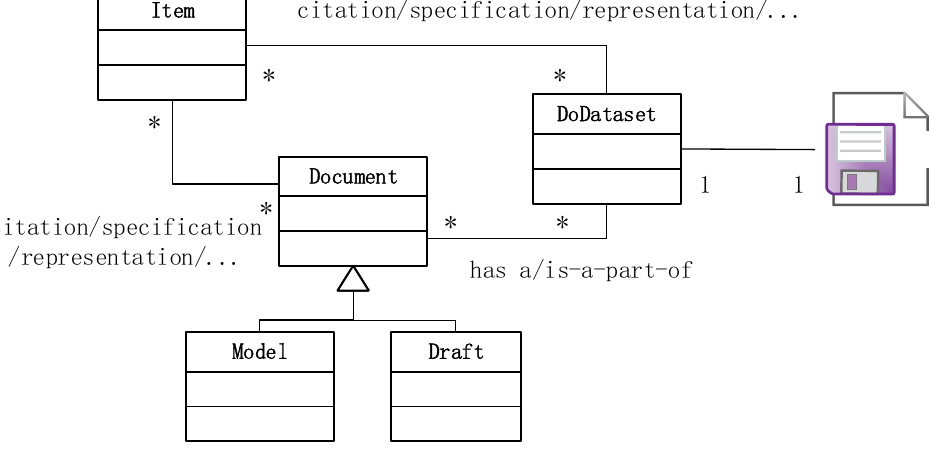
Figure 11. Document Management Data Model (1, * represent the one and Figure 11